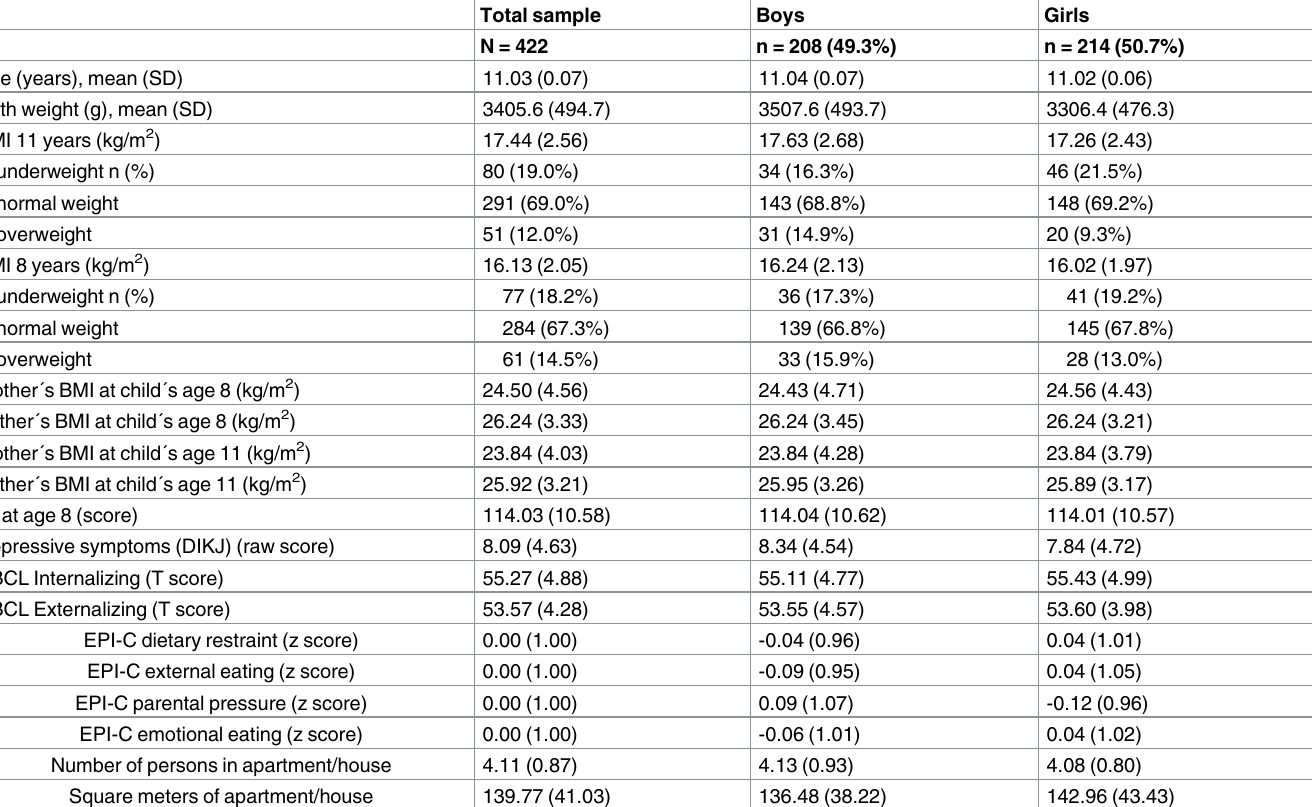
Table 1. Sample characteristics of participating children in the total sample and stratified according to gender with means and standard devia- tions (SD) of metric variablesand absolute numbers and percent of categorical variables in